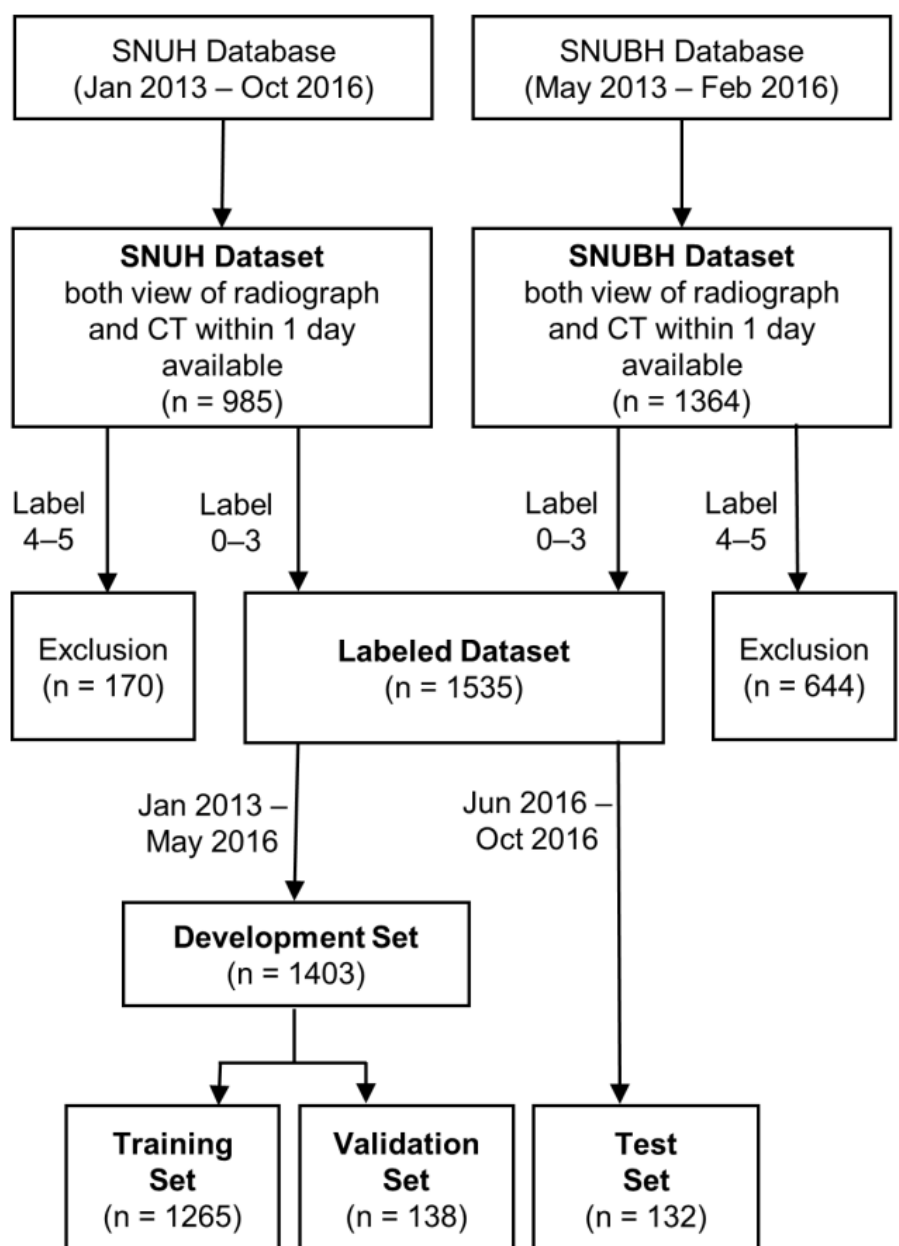
Figure 1. Flowchart of clinical datasets for training, validation, and